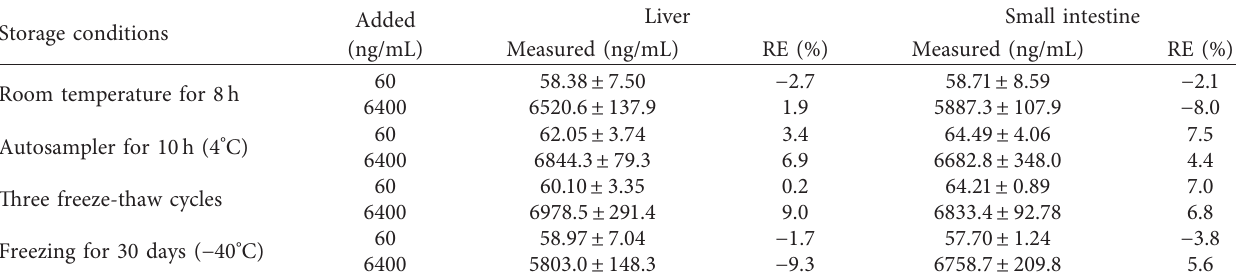
Table 4: Stability data of crizotinib in mouse liver and small intestines under various storage conditions ( n � 3). Storage